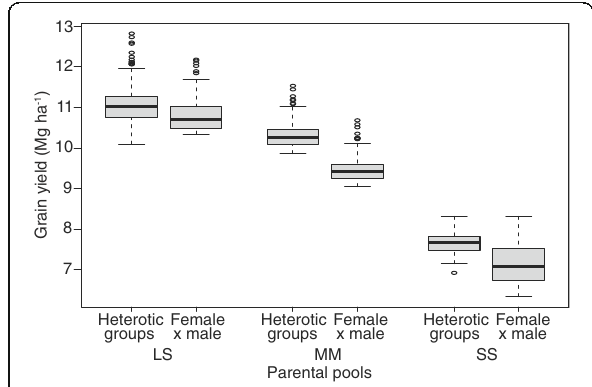
Fig. 5 Distribution of predicted hybrid performances for 256 best performing female x male crosses in comparison to heterotic groups of size